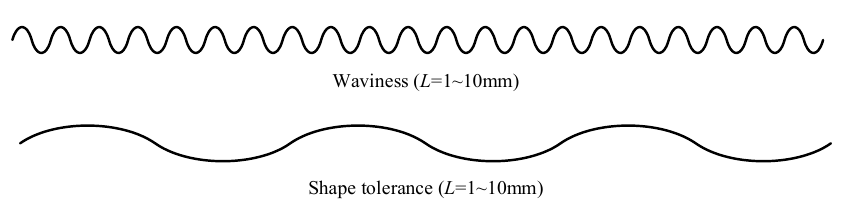
Figure 6. Decomposition diagrams of the surface morphology.